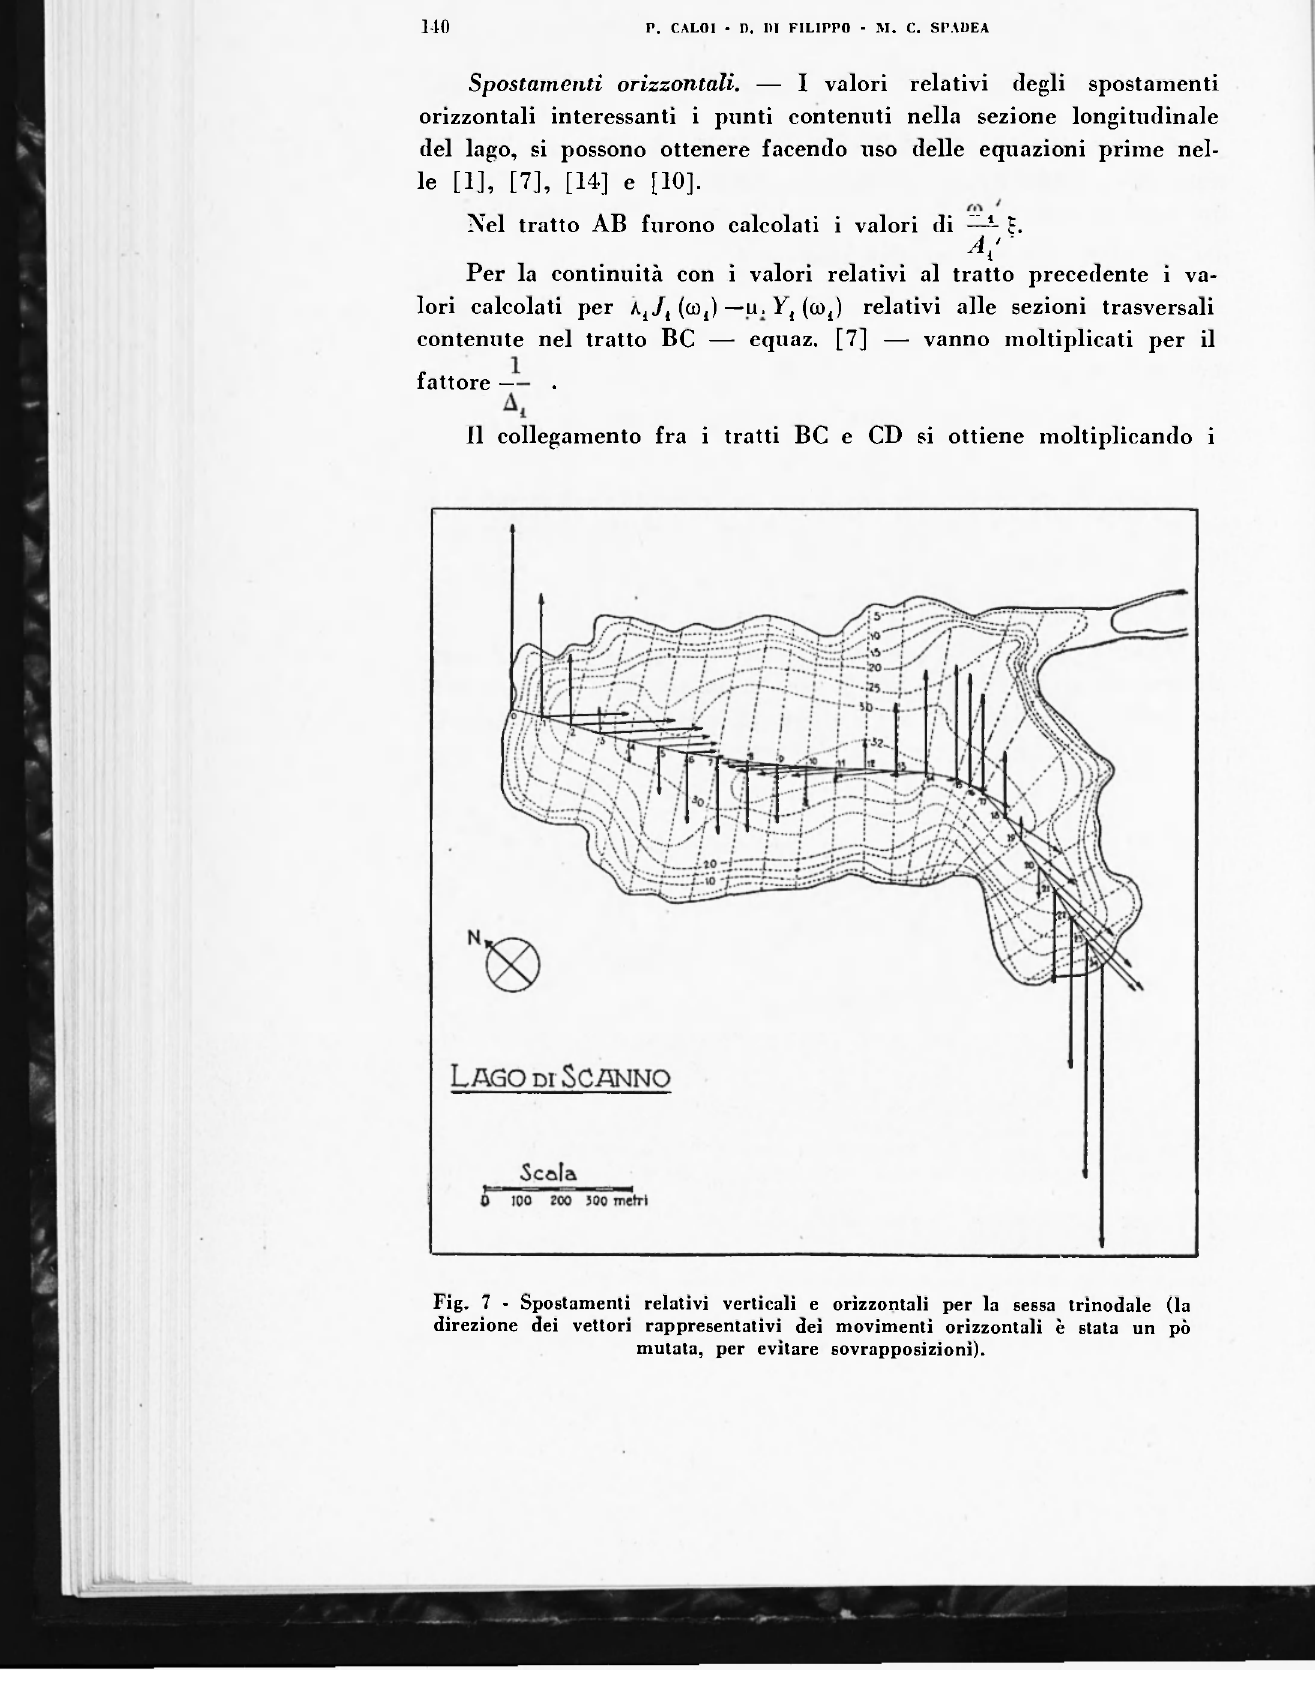
Fig. 7 - Spostamenti relativi verticali e orizzontali per la sessa trinodale (la direzione dei vettori rappresentativi dei movimenti orizzontali è stata un pò mutata, per evitare